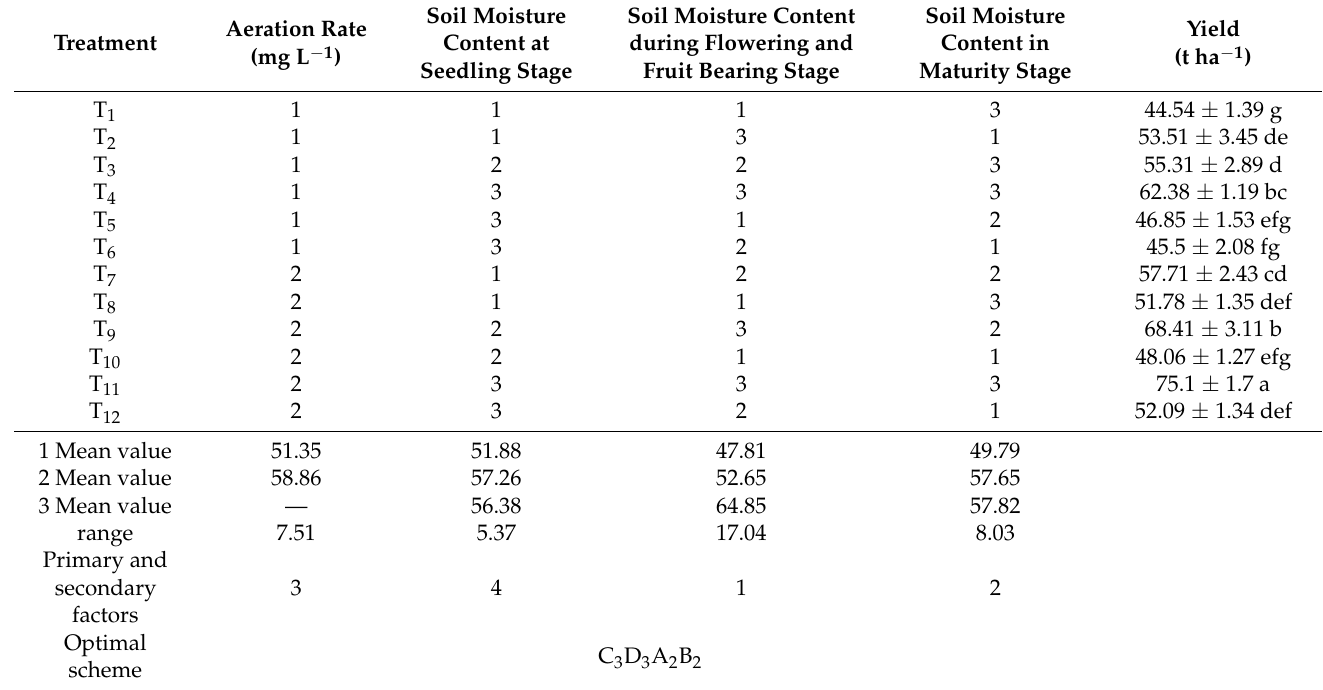
Table 3. Range analysis of